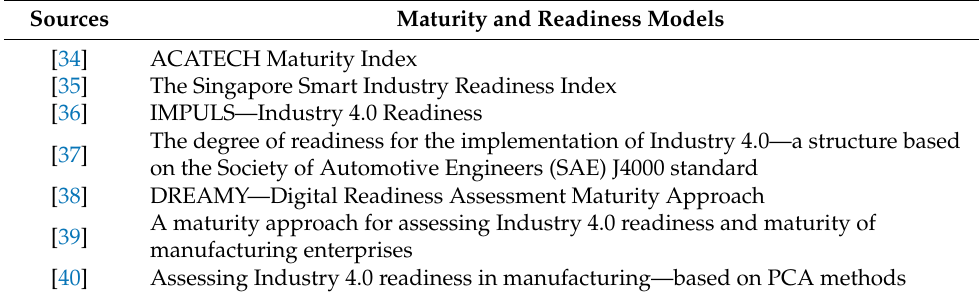
Table 2. Publications devoted to the subject of assessing readiness for industry 4.0 and digital maturity.